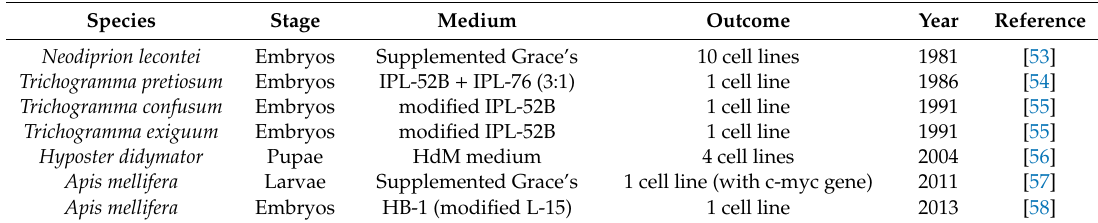
Table 2. Permanent cell lines derived from hymenopteran